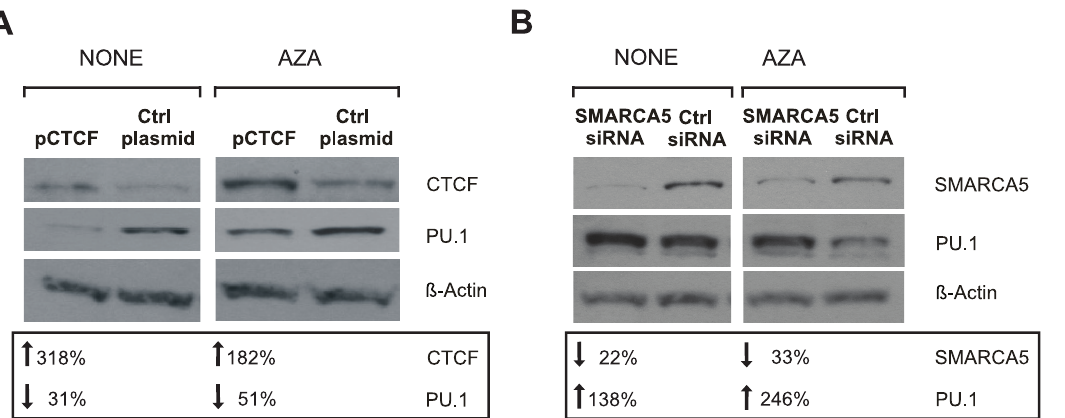
Figure 7. Perturbation experiments indicate effects of CTCF and SMARCA5 on PU.1 expression. A: Western blot of PU.1 in OCI-M2 after CTCF overexpression at 72 hrs. OCI-M2 cells were transfected with CTCF-encoding plasmid (pCTCF) or pBSK + as negative control plasmid (Ctrl plasmid). AZA treatment (AZA) is indicated on the top of the lines. B: Western blot of PU.1 in OCI-M2 after downregulation of SMARCA5 at 72 hrs. OCI-M2 cells were transfected with siRNA to SMARCA5 and treated or untreated with AZA. Protein lysates were resolved by SDS/PAGE. Membrane with blotted proteins was immunostained with antibody to CTCF or SMARCA5, and PU.1. ß-actin was used as a control of sample loading. Level of down/up-regulation (small table) was determined by densitometry.